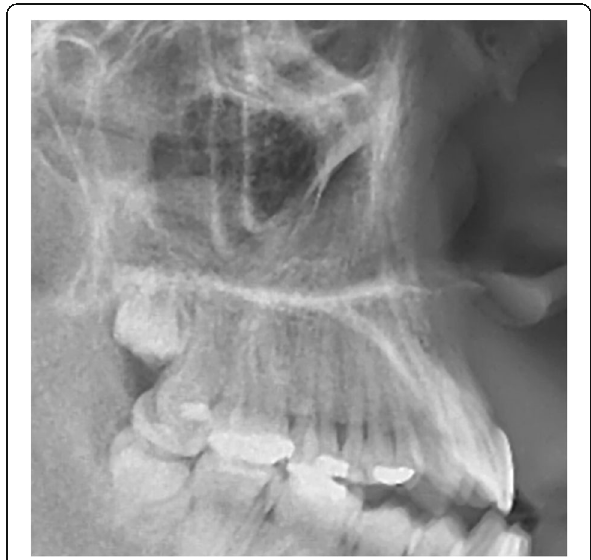
Fig. 2 Example of MPDD. The third molar was potentially blocked